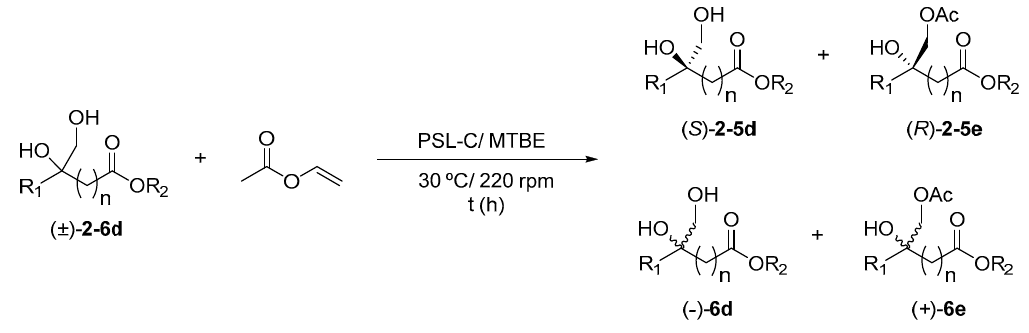
Table 3. PSL-C catalysed kinetic resolution of racemic diols 2 – 6d in tert -butyl methyl ether (TBME) at 30 °C using vinyl acetate as the acyl donor.